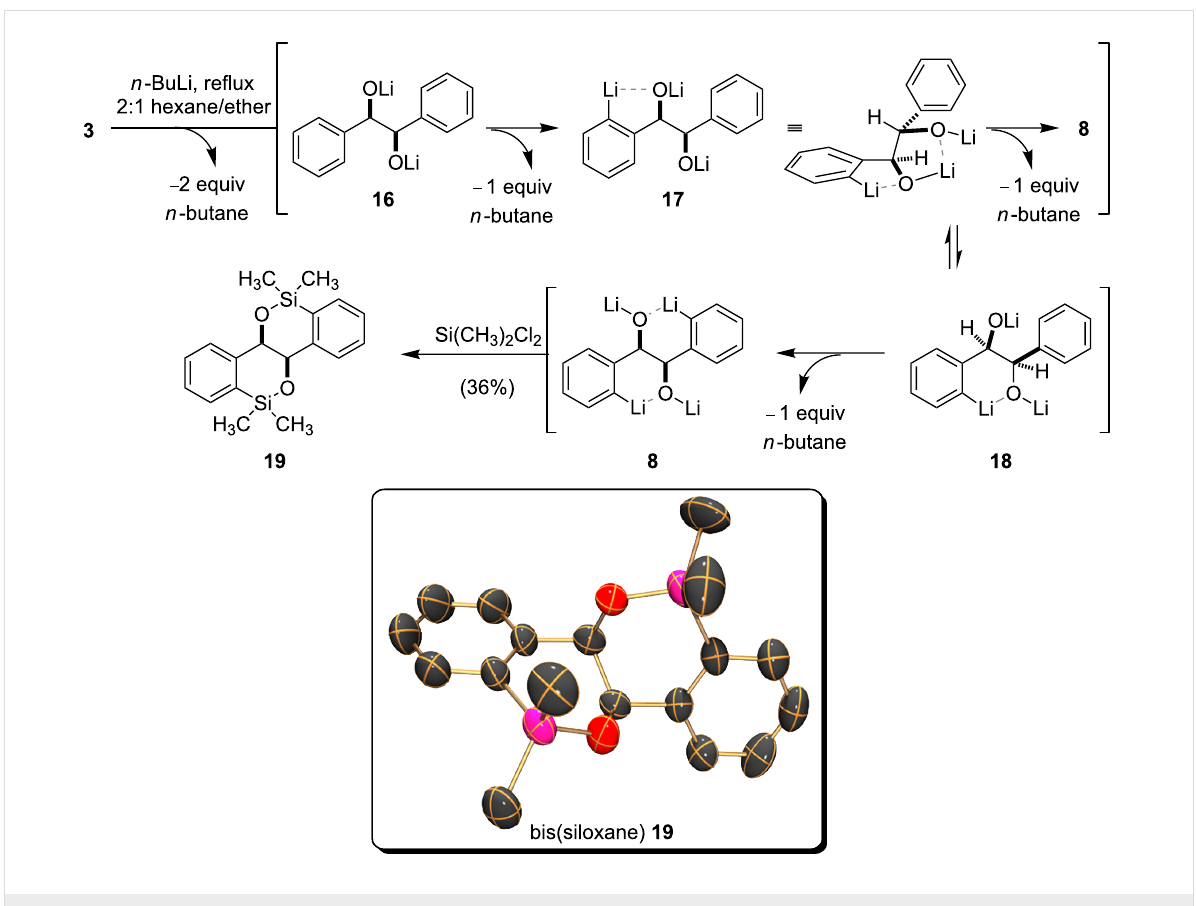
Scheme 2: Formation of the tetralithio intermediate 8 and the X-ray crystal structure of the bis(siloxane) 19 .